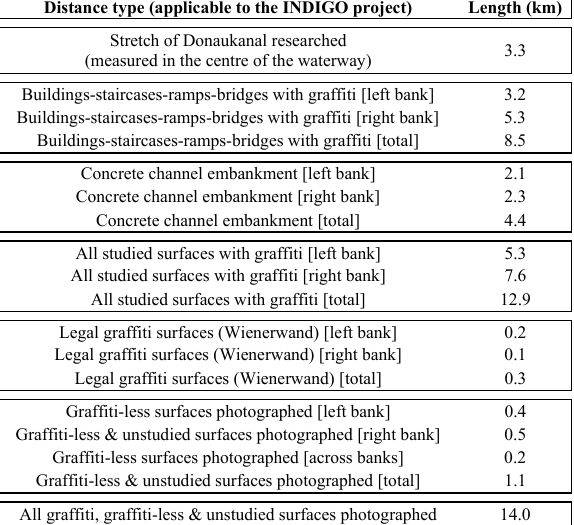
mm ones) acquired on the opposite sides of the Donaukanal.